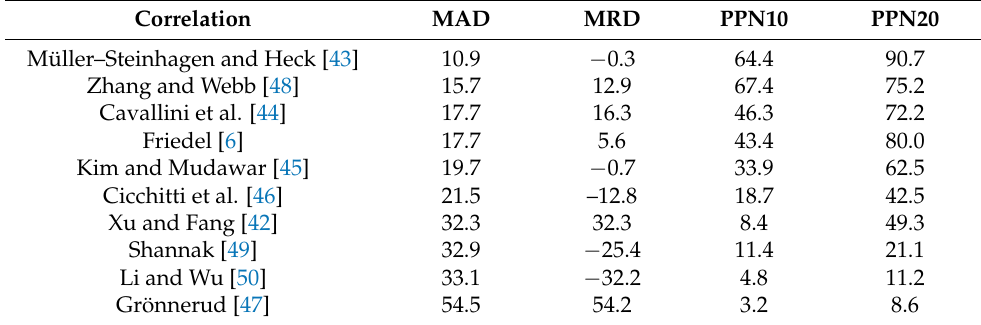
Table 4. Prediction deviations of the existing FPD correlations (%).